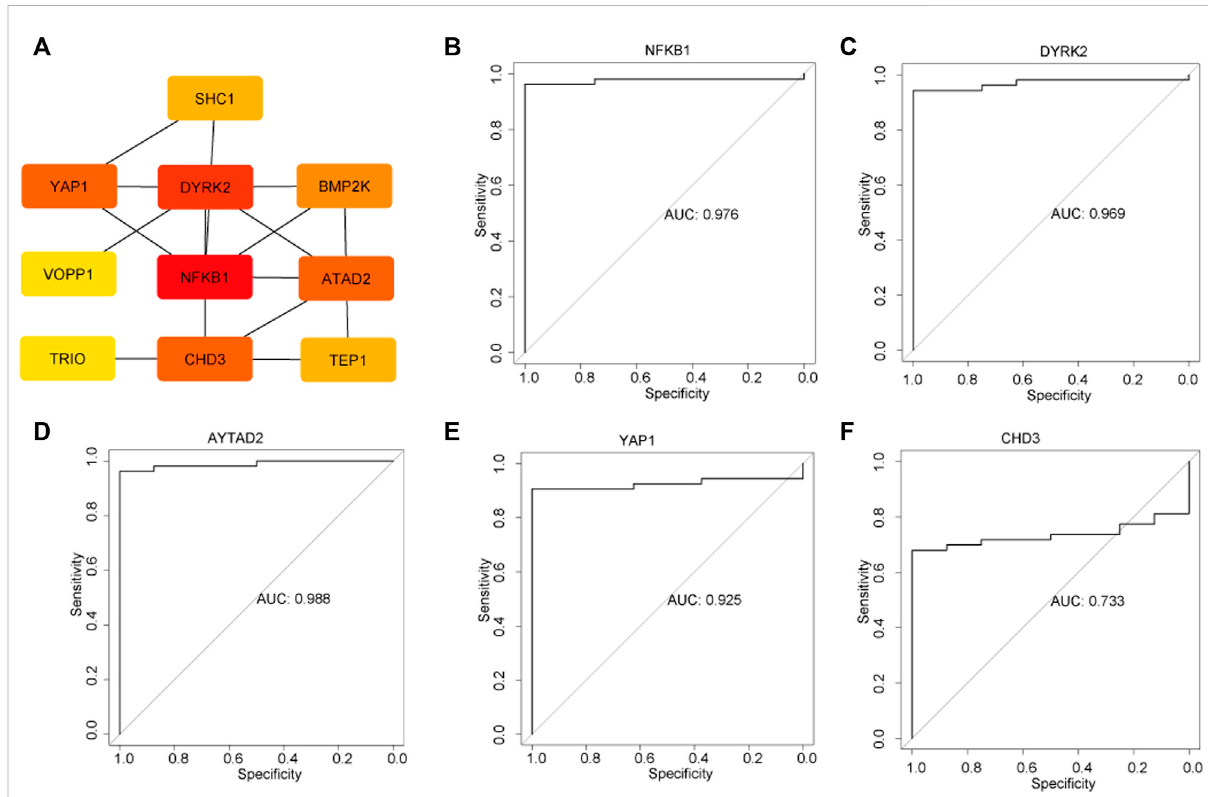
FIGURE 5 Identi fi cation of hub genes and the evaluation the diagnostic value of each hub gene. (A) Top fi ve hub genes were selected by the Cytohub program. The AUC values of fi ve hub genes: NFKB1 (B) , DYRK2 (C) , AYTAD2 (D) , YAP1 (E) , CHD3 (F) .